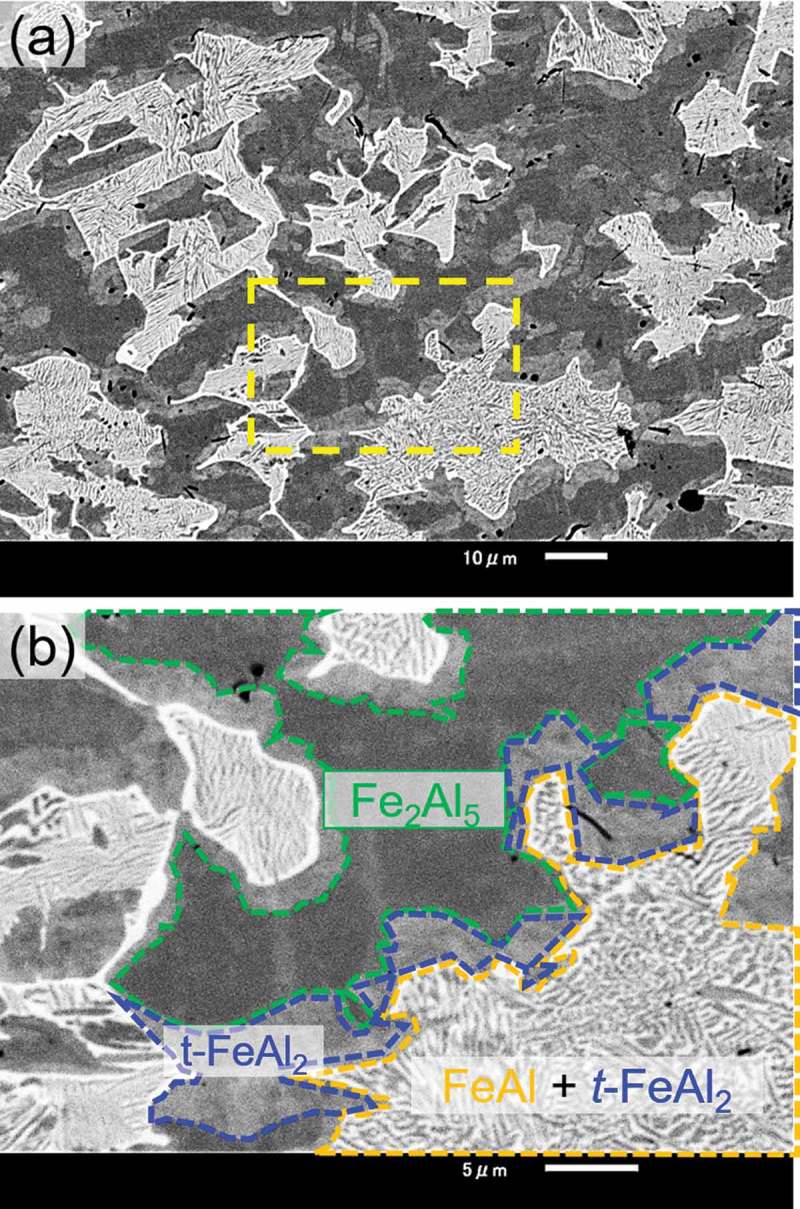
(a) SEM-BECI image of the sample synthesized at 20 GPa and 2073 K. (b) Magnified image shows the growth of t-FeAl2 at phase boundaries between a lamellar matrix of FeAl + t-FeAl2 and Fe2Al5.